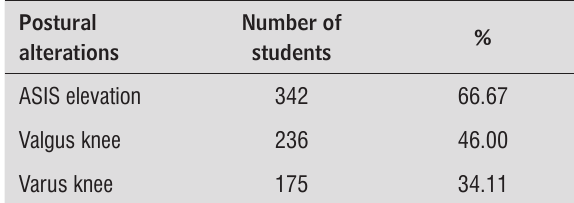
Table 2 - Prevalence of alterations in the ASIS and knees in the anterior view